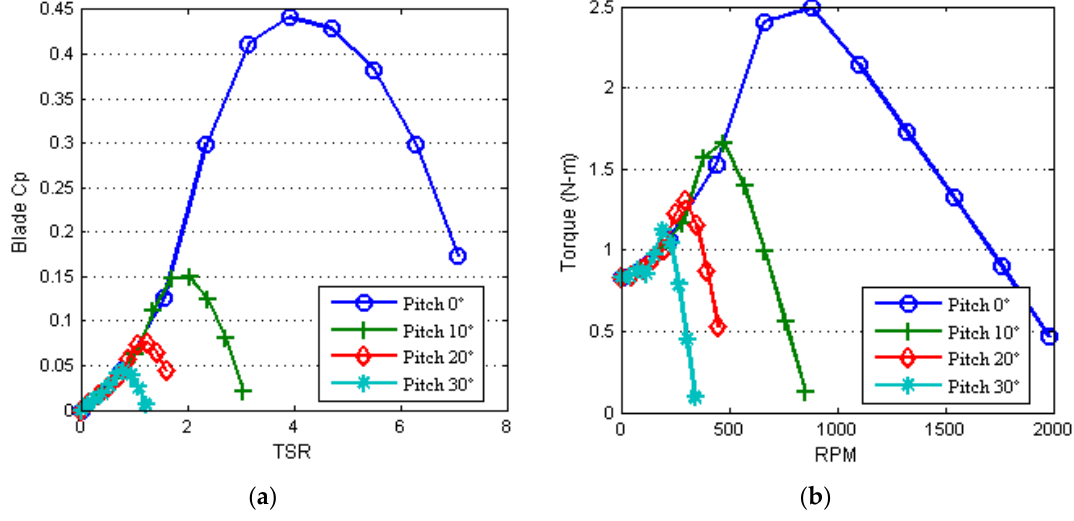
Figure 7. Performance curves for sample pitch control angles, simulated by HAWT-Perform at 12 m/s: ( a ) Cp vs. TSR curves; and ( b ) torque vs. RPM curves.